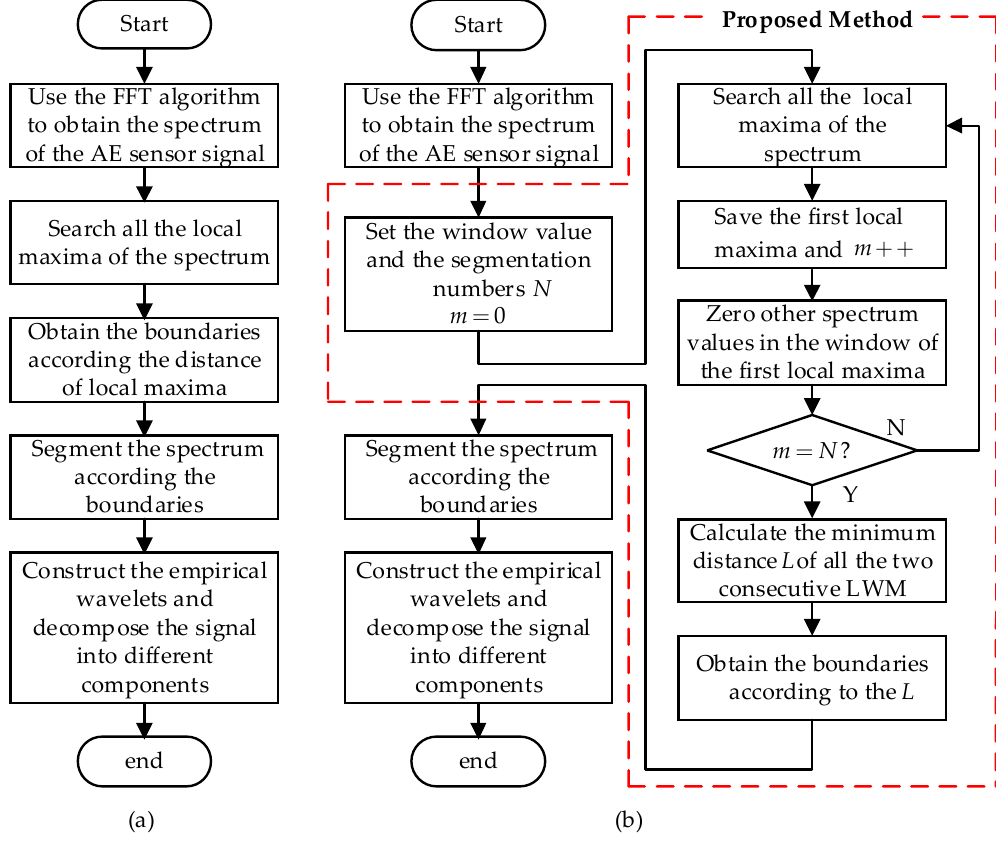
Figure 2. Flowcharts of ( a ) the EWT method and ( b ) the proposed LWM-EWT method.